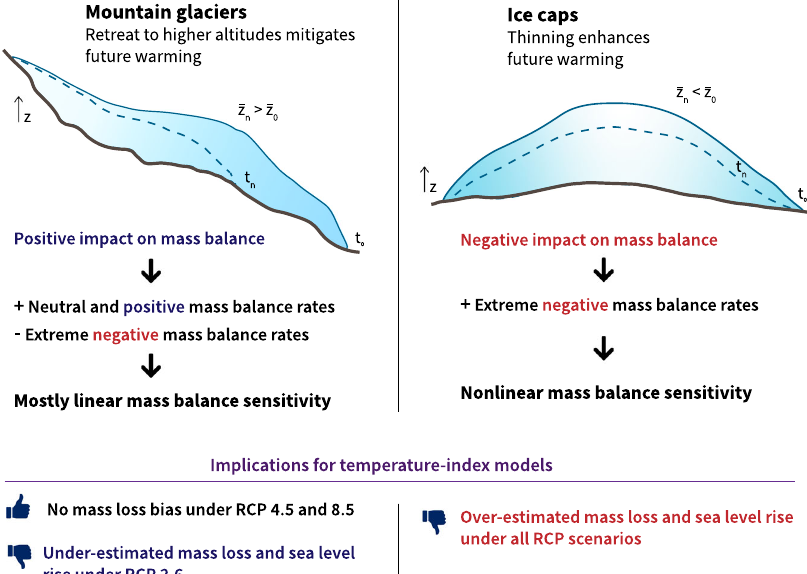
Fig. 5 Main implications of nonlinear mass balance response to future warming and topographical feedback for mountain glacier and ice cap projections. Glacier topography is a crucial driver of future glacier projections and is expected to play an important role in determining the magnitude that nonlinearities will have on the mass balance signal: ice caps and large fl atter glaciers are expected to be more in fl uenced by these nonlinear sensitivities than steep mountain glaciers in a warming climate. Graphics inspired by Hock and Huss 40